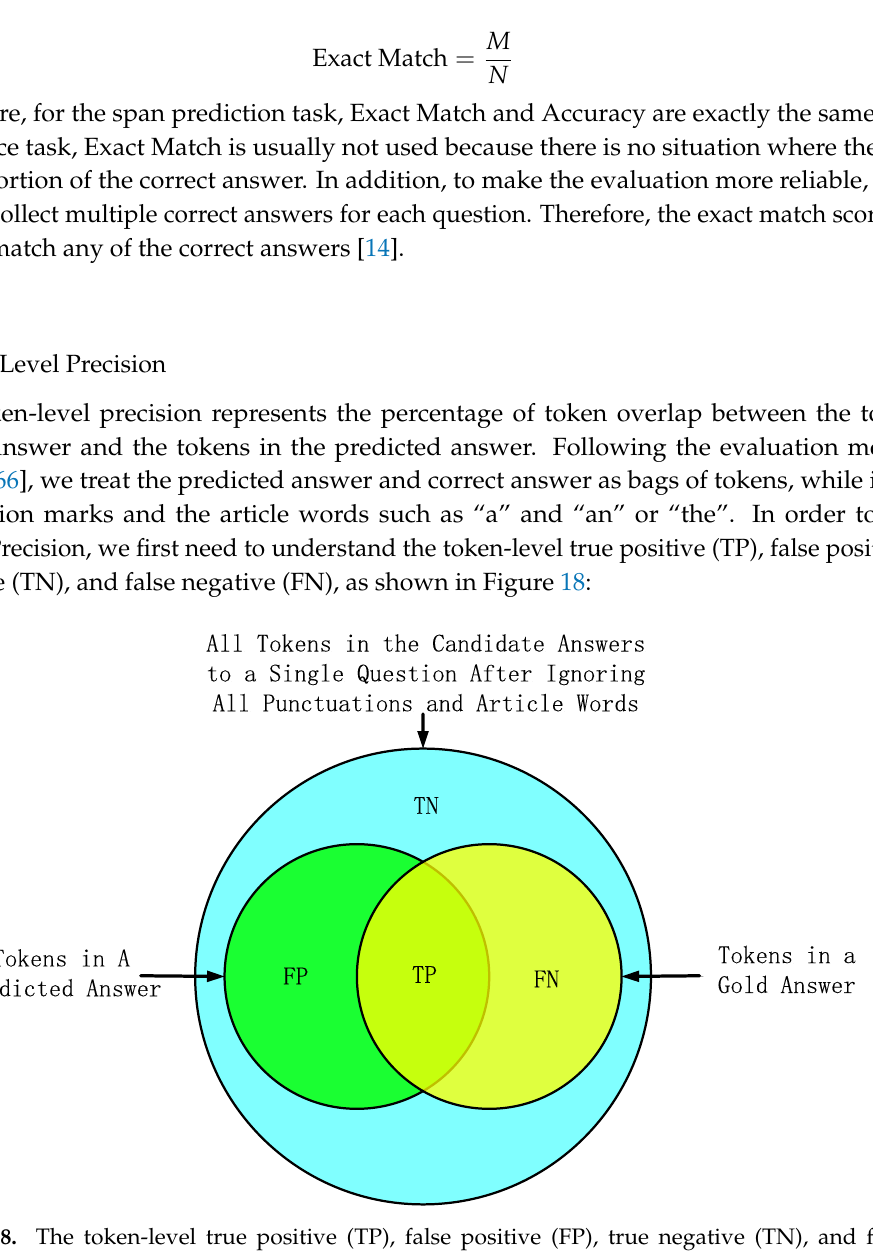
Figure 18. The token-level true positive (TP), false positive (FP), true negative (TN), and false negative